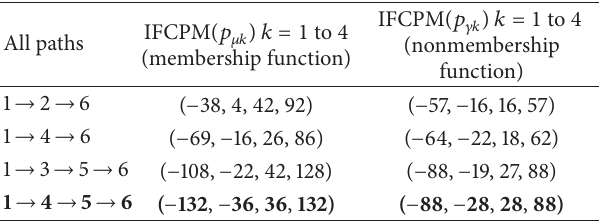
Table 4: The total slack (Atanassov) intuitionistic fuzzy time of path 𝑝 𝑝 𝜇𝑘 & 𝛾𝑘